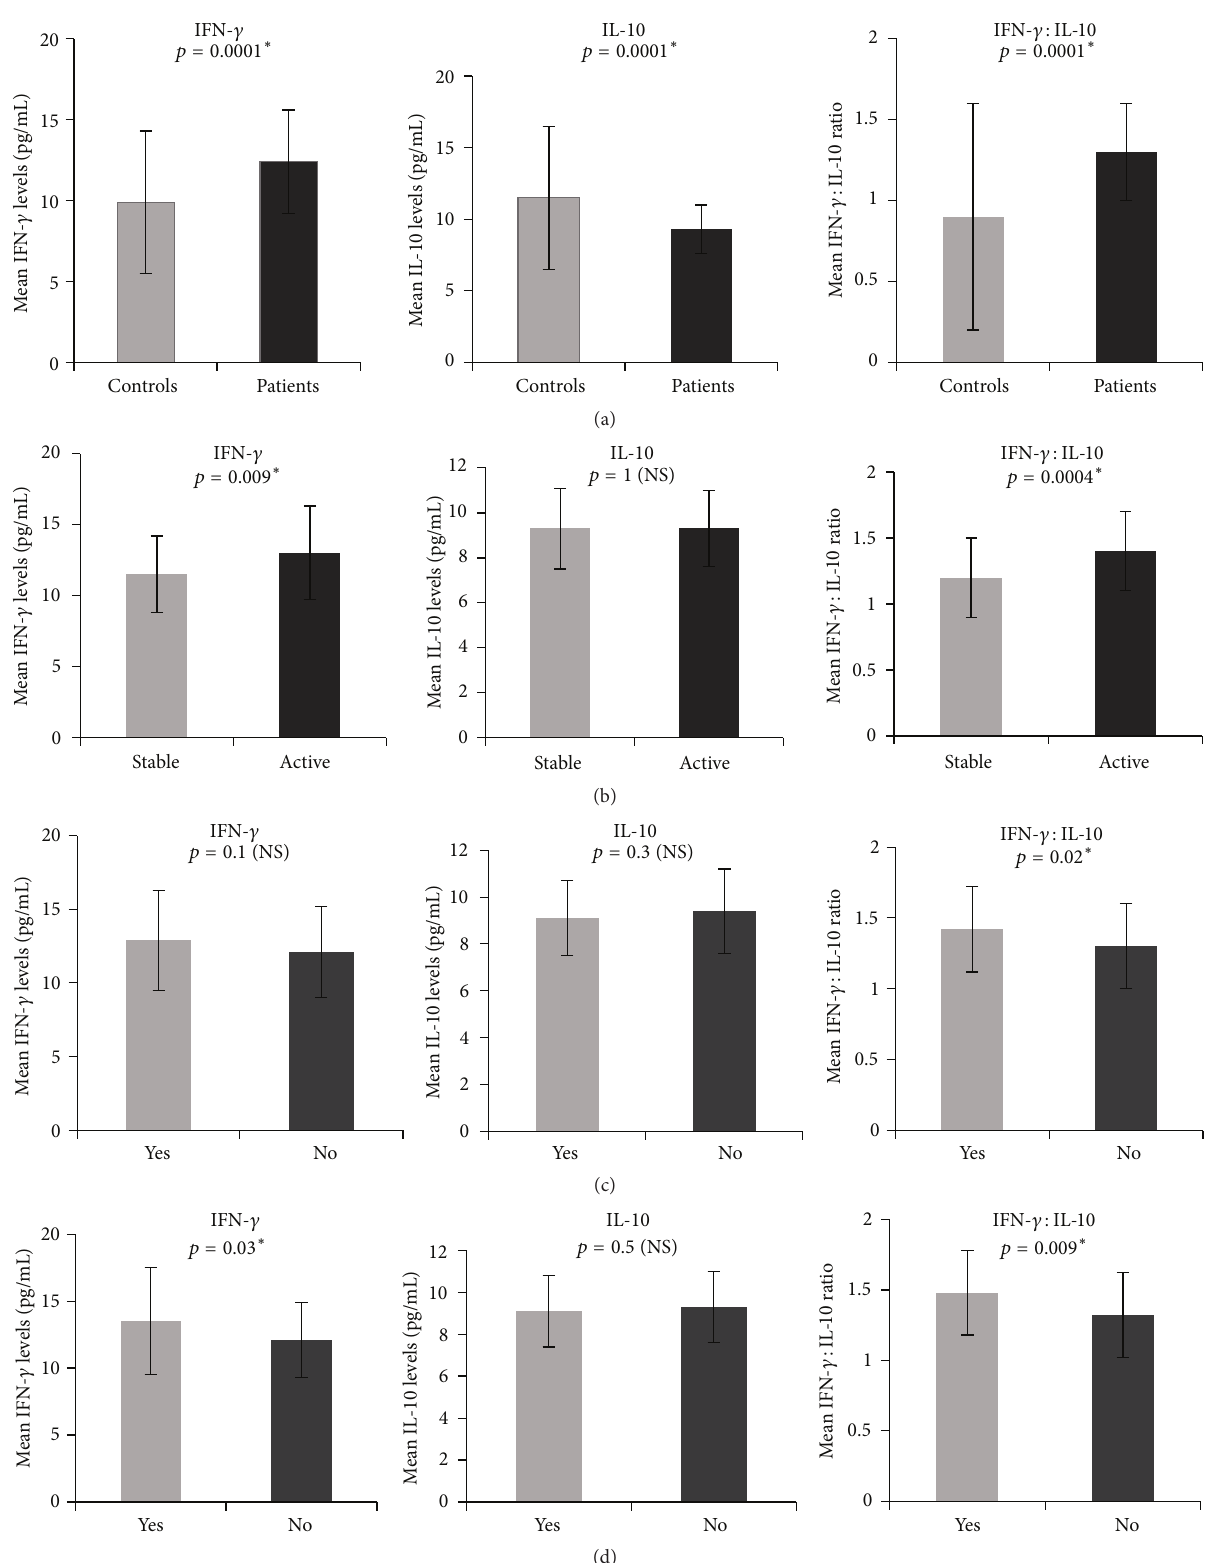
Figure 1: Representing mean IFN- 𝛾 , IL-10, and IFN- 𝛾 :IL-10 ratio in (a) patients and controls, (b) patients with active and stable vitiligo, (c) patients with family history of vitiligo, and (d) patients with a habit of smoking and alcohol